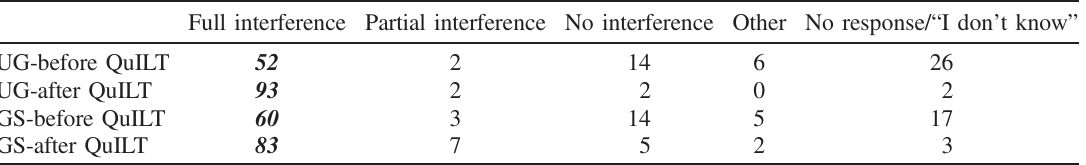
TABLE IX. Percentages of undergraduate (UG) and graduate students (GS) with different answers on Q3 (full interference, partial interference, no interference, other, and no response/ “ I don ’ t know ” ). Bold italic indicates correct